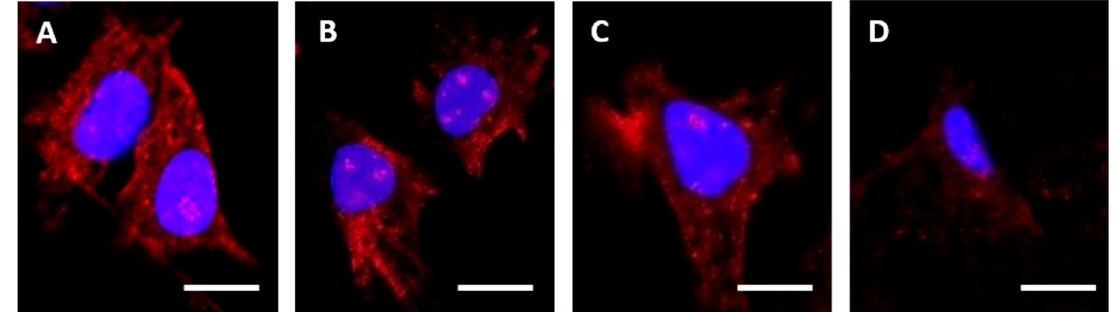
Figure 3. RBGO1 cell surface binding is greater than RBGO2, RBGO3 and RBGO4. ( A–D ) HEC1A endometrial cancer cells were incubated in medium containing RBGO1 ( A ), RBGO2 ( B ), RBGO3 ( C ), or RBGO4 ( D ) antibodies at 10 μ g/mL for 240 min. After incubation, the cells were washed and fixed. Cell surface bound antibody was imaged via fluorescently labeled secondary antibodies and nuclei stained with 4',6-Diamidine-2'-phenylindole dihydrochloride (DAPI). Images were acquired on a Zeiss LSM 710 confocal microscope and analyzed using the Zen 2012 image analysis software. Scale bars = 50 μ m.